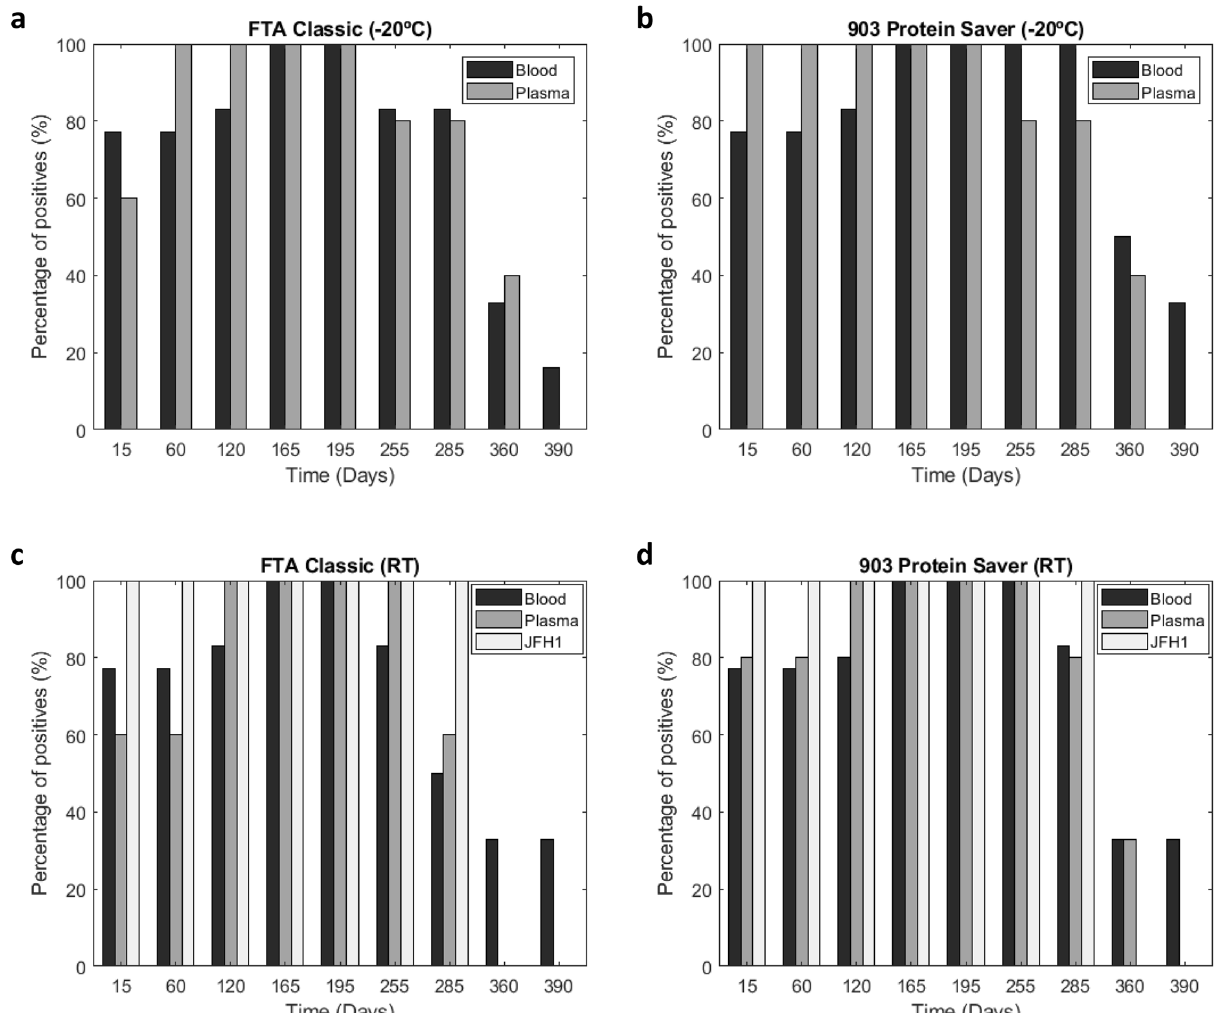
Figure 2. HCV RNA detection in DBS by RT-PCR followed by nested PCR amplification at the different time points analysed, for blood and plasma samples stored in FTA Classic cards ( a ) or 903 Protein Saver cards ( b ) at − 20 °C, and in FTA Classic cards ( c ) or 903 Protein Saver cards ( d ) at room temperature (RT). Histograms represent the % of positive samples at the different time points